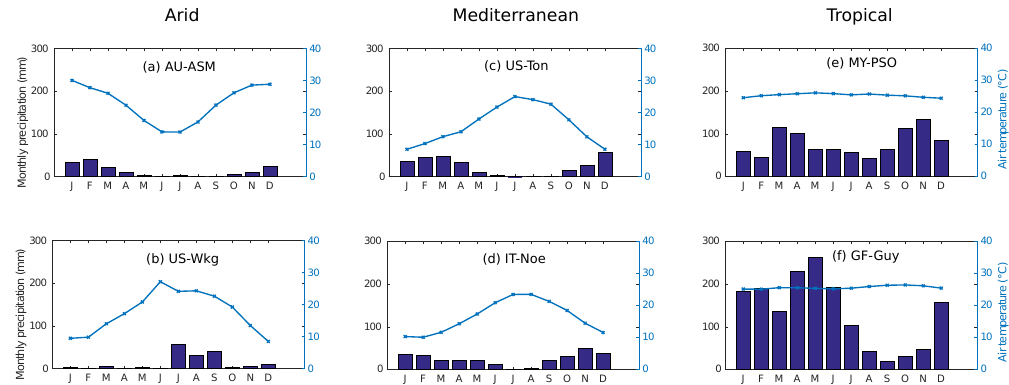
Figure 2. Mean monthly air temperature and precipitation for the studied periods, sorted according to climate type. Arid sites: ( a ) AU-ASM and ( b ) US-Wkg; Mediterranean sites: ( c ) US-Ton and ( d ) IT-Noe; and tropical sites: ( e ) MY-PSO and ( f )